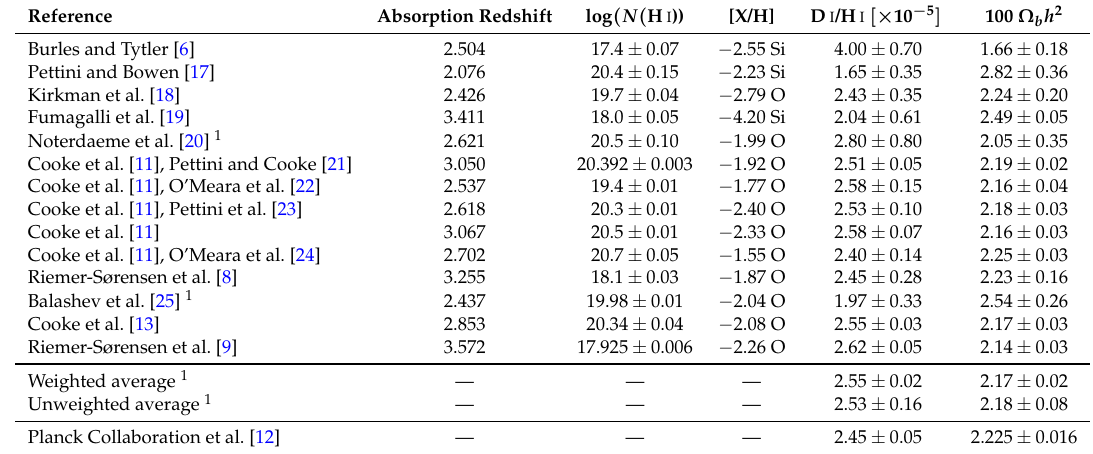
Table 1. The sample of D I /H I measurements from Riemer-Sørensen et al.